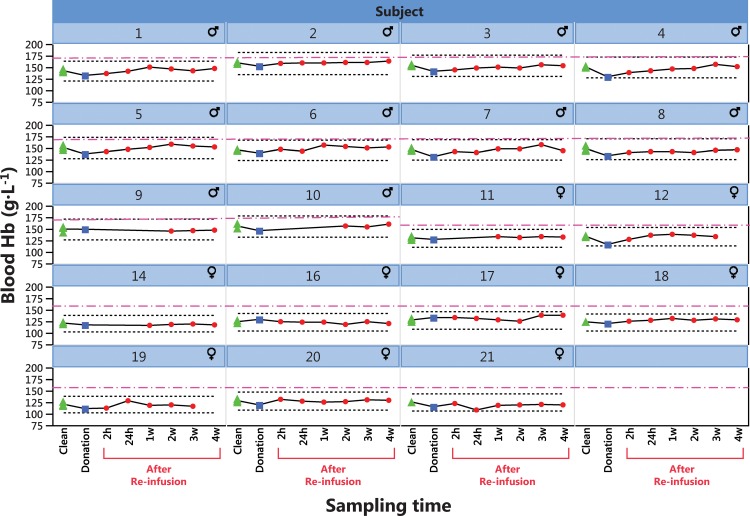
Part B of the Study.Individual blood [Hb] (g·L-1) from ten men and nine women during a ten week period before and after autologous blood transfusion. One (women) and two (men) units (450 mL each) whole blood was withdrawn, with re-infusion of the washed, cryo-preserved RBC fraction five weeks later (Fig 1). A total of 190 samples are included from women (N = 80) and Men (N = 110). Over time, samples are group into Clean (N = 57), Donation (N = 19) and Doped (N = 114. Upper limit for [Hb] set by some some sport federations, such as FIS, for women at 160 g·L-1 and for men a 170 g·L-1 is indicated by dash-dot purple lines. ▲(green) Clean (triplicate samples), ■ (blue) After blood donation, ● (red) After RBC re-infusion.